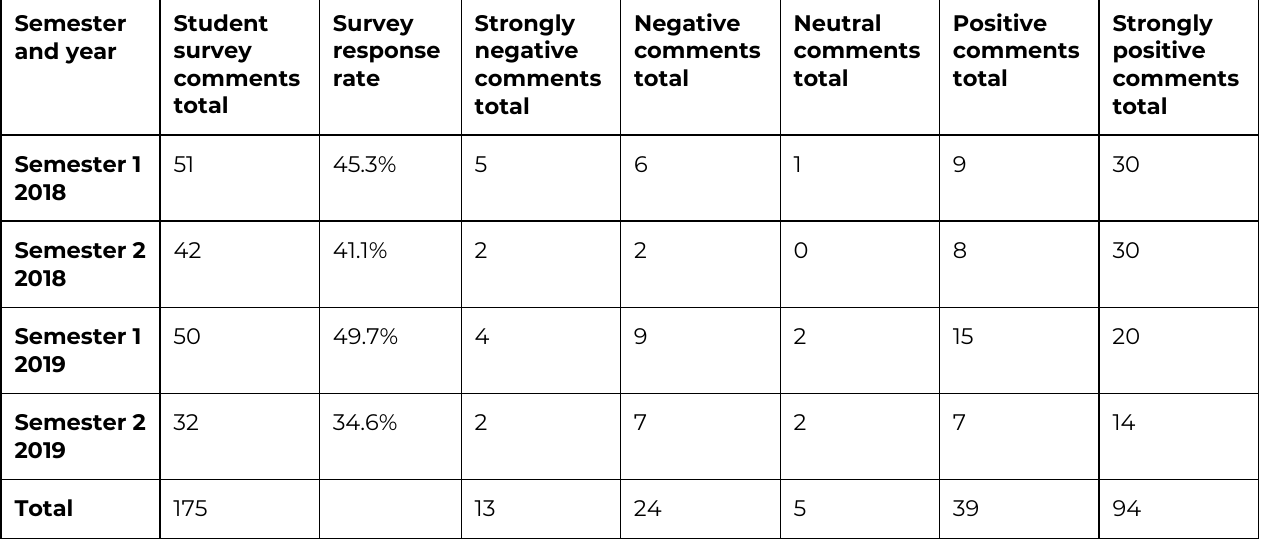
Table 1: Overview of qualitative comments